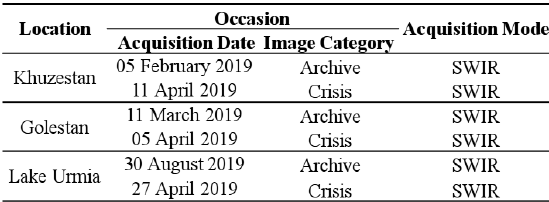
Table 2. Specifications of validation datasets obtained from Sentinel-2 images